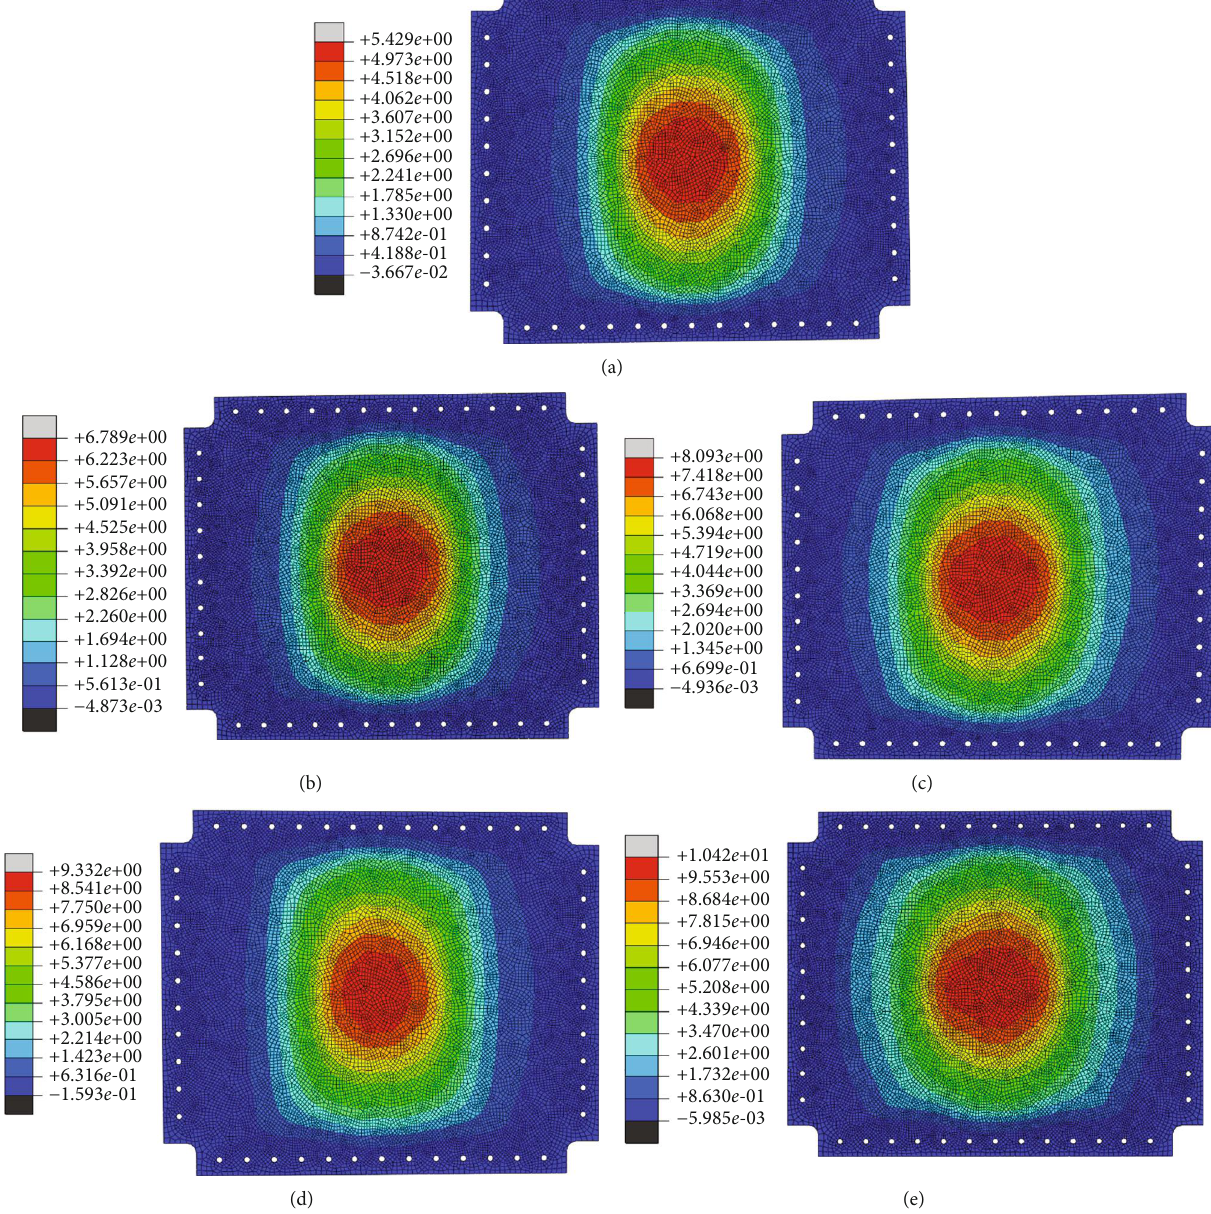
Figure 26: Skin displacement clouds at di ff erent bird body speeds. (a) 60 mph, (b) 70mph, (c) 80 mph, (d) 90mph, and (e)